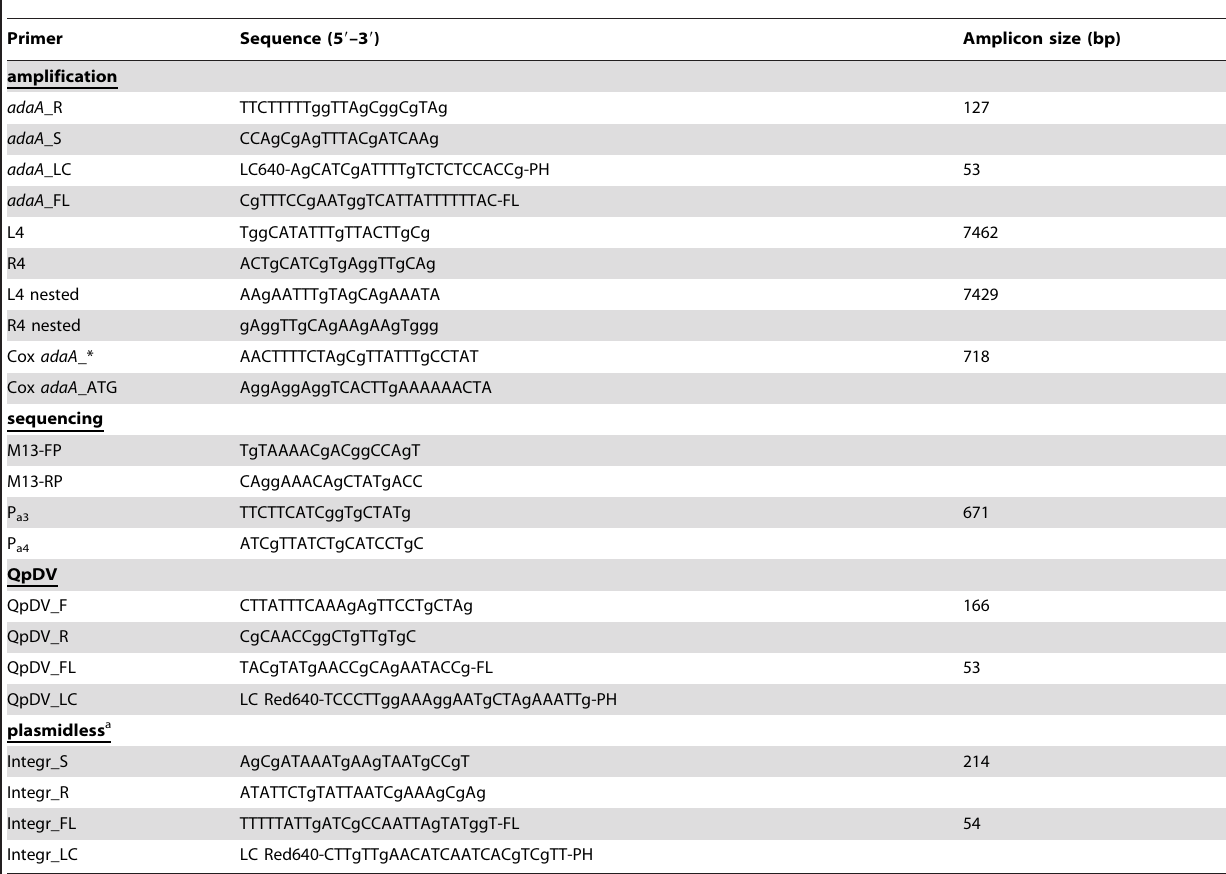
Table 3. Primers and probes used in this